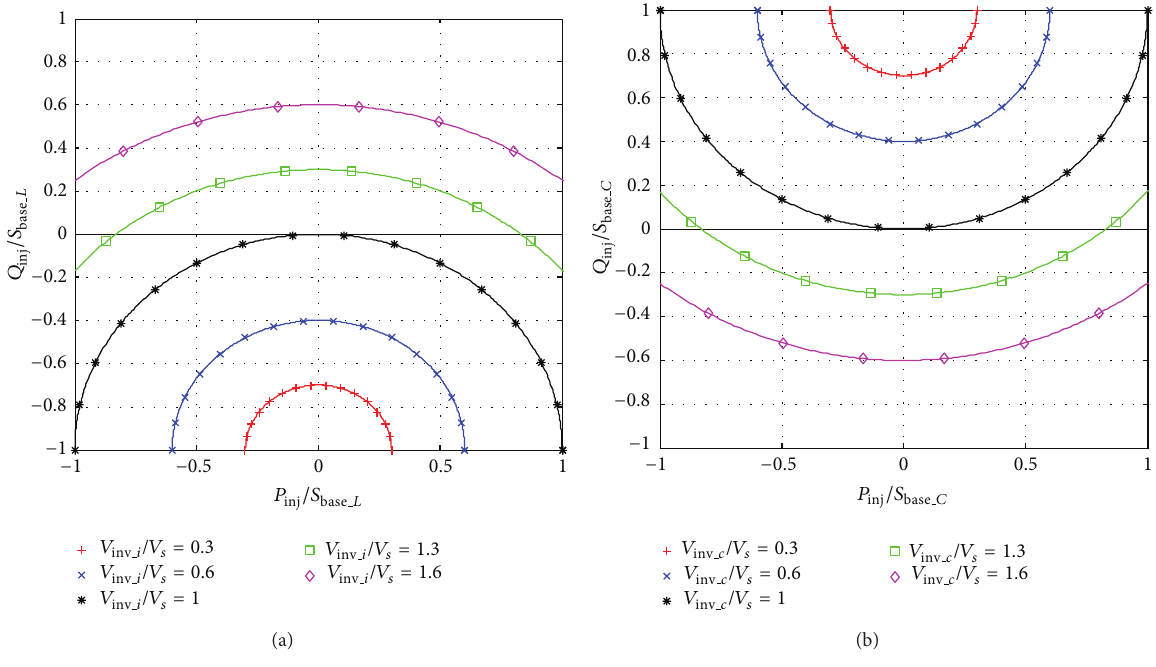
Figure 3: Top view of Figure